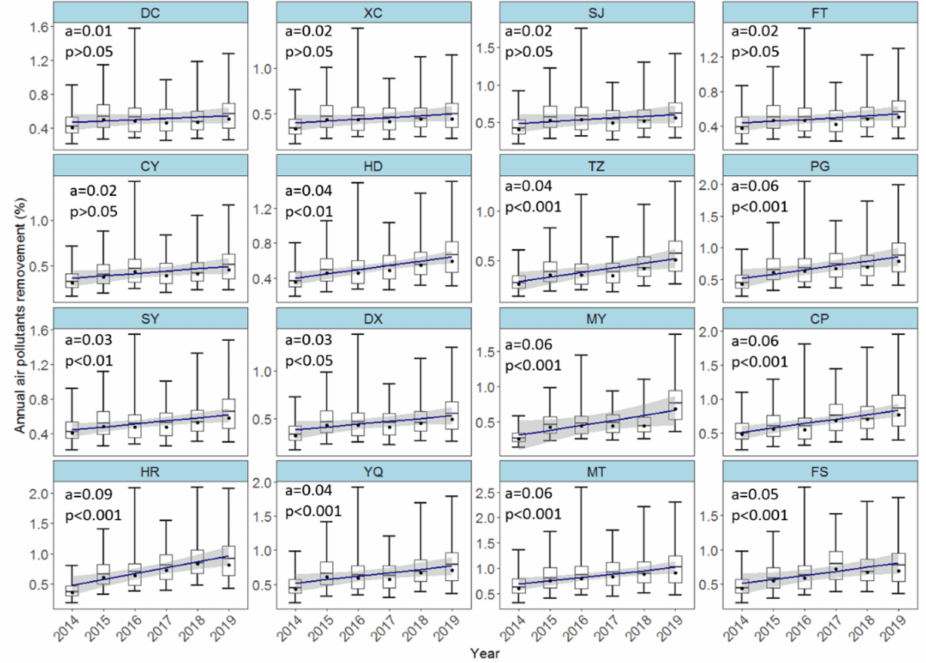
Figure 6. Annual removal proportion of atmospheric NO 2 in the 16 districts of Beijing. The boxplots represent the range of removal proportion. Annual average removal proportions are represented by dots. Linear regressions were performed on the annual average removal proportion and